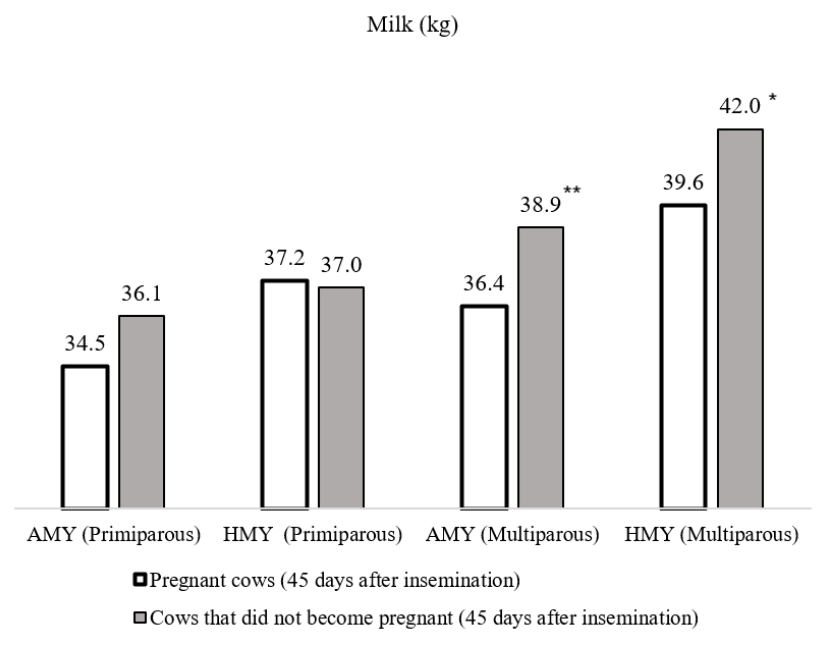
Figure 3. The milk yield (kg) of cows 0–45 days p < 0.05, ** p < 0.001 after insemination (*—average values of progesterone in milk between primiparous and multiparous cows are statistically significantly different) . Table 3. Correlation of progesterone in milk with milk yield of cows (* p < 0.05—Pearson’s correlation is statistically